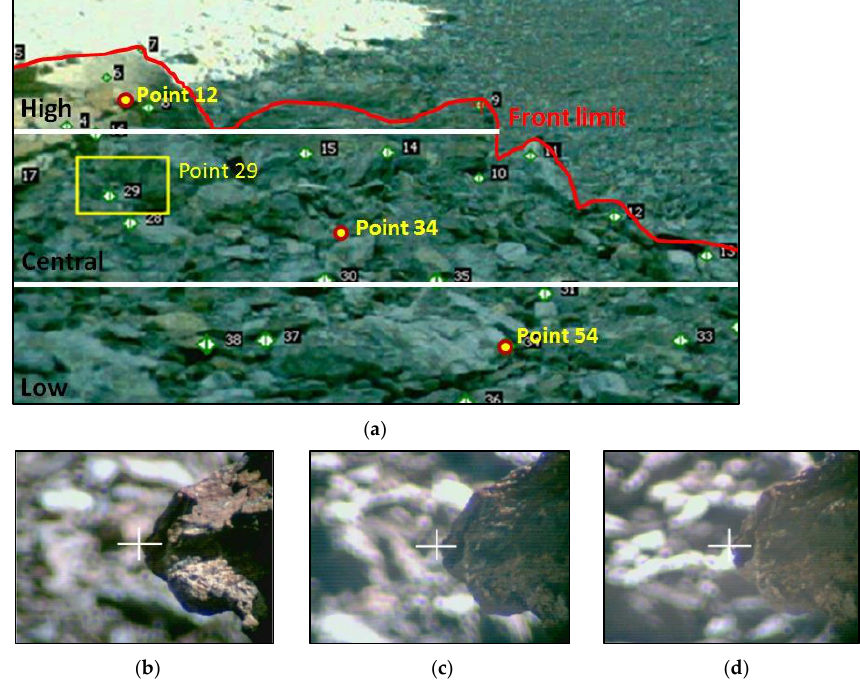
Figure 3. ( a ) Image (low quality) obtained using the total station with the position of the points measured on the front of the rock glacier. ( b ) Detailed image of point 29 in 2007, obtained with the total station. ( c ) The same point 29 in the year 2008. ( d ) Point 29 in the year 2009.